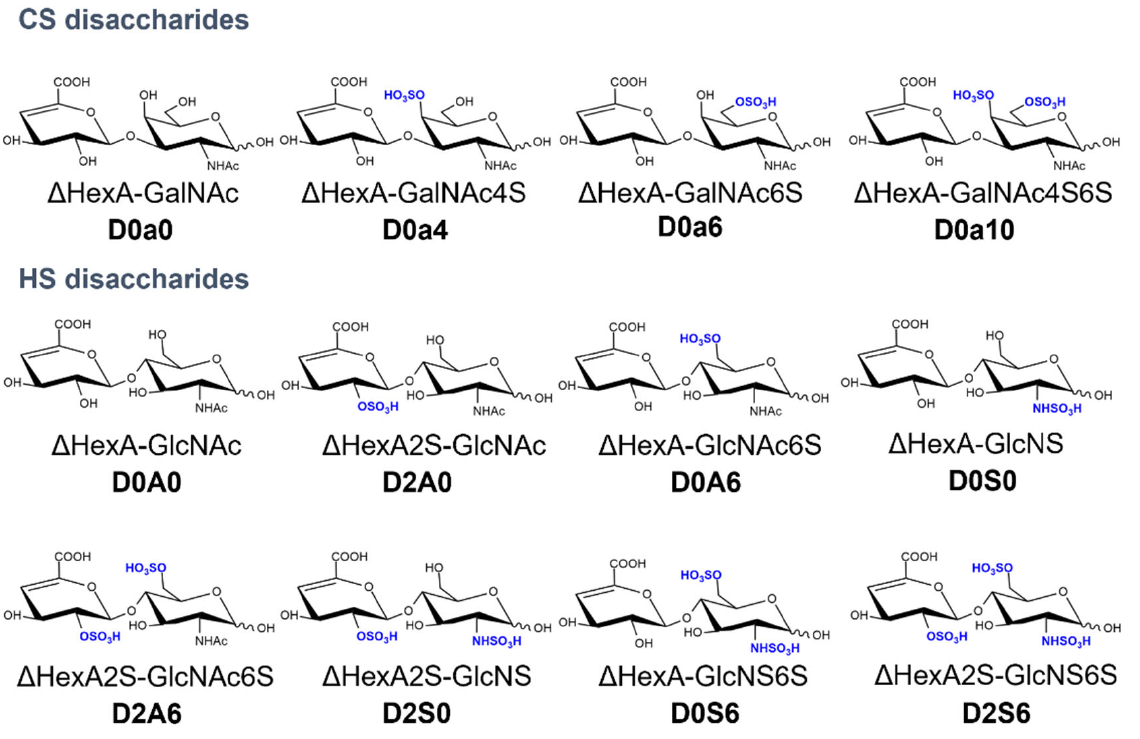
Figure 1. The chemical structures, traditional names, and Lawrence codes of the analyzed disaccha ‐ rides.